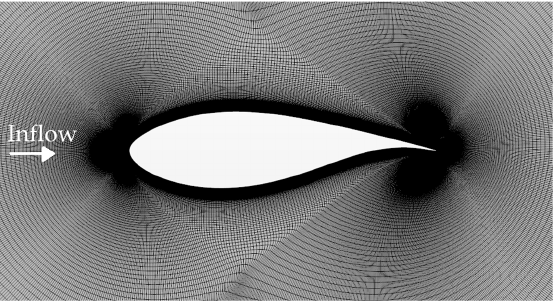
Figure 1. DU91W(2)250 mesh, centered view. The snapshot shows a clean profile without any flow control device implemented.